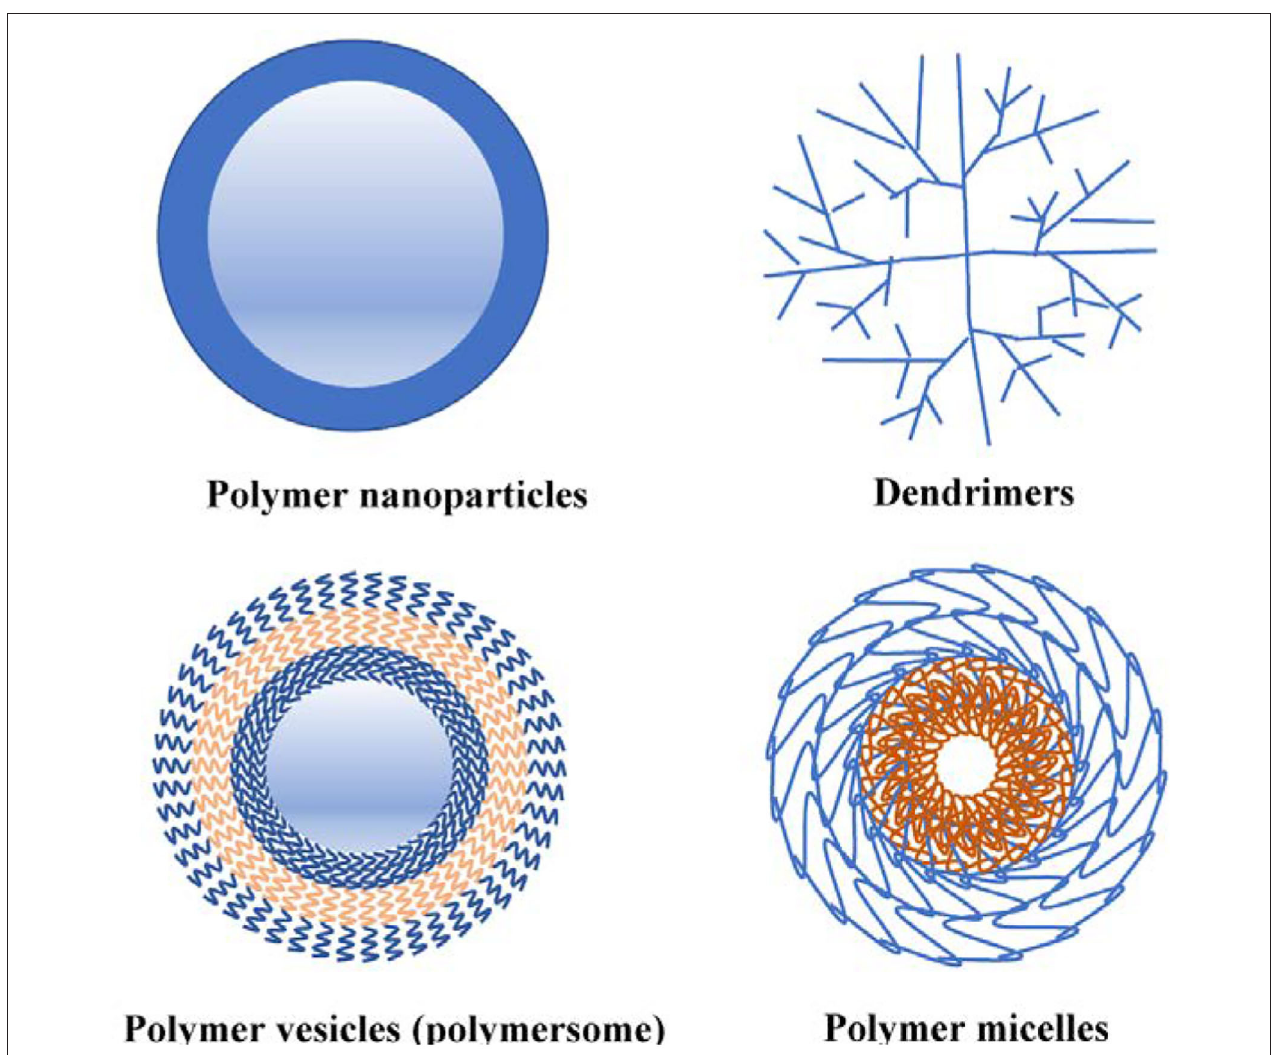
FIGURE 3 | Different types of polymer-based